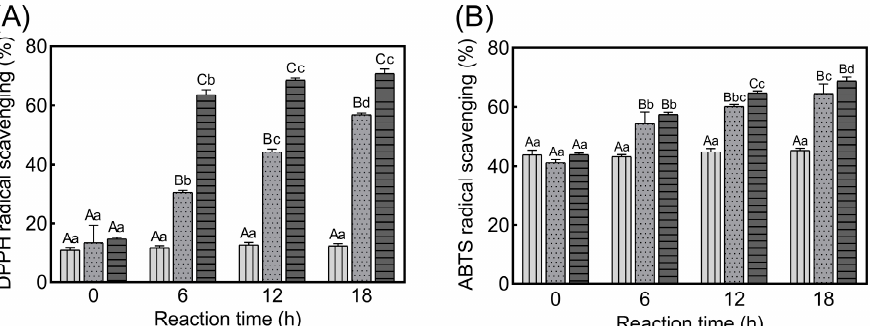
Figure 3. DPPH and ABTS radical scavenging activities of glycated collagens. ( A ): DPPH radical scavenging activity; ( B ): ABTS radical scavenging activity. C-AO ( ), C-Glu ( ), C-Sor ( ). Different capital letters A – C indicate significant differences among the three collagen groups at the same reaction time. Different lowercase letters a – d indicate significant differences among the different reaction times in the same collagen group.